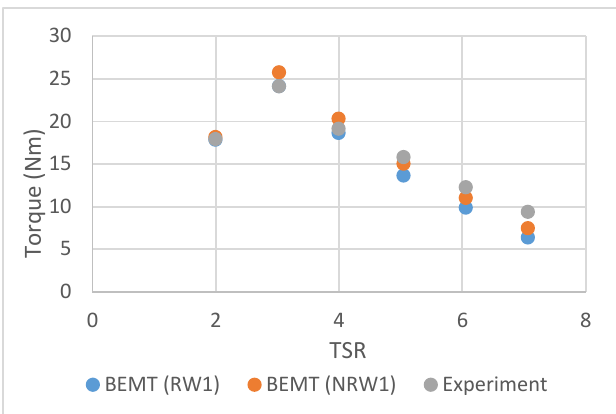
Figure 14. Torque comparison between BEMT calculations and experimental data for the inflow profiles with and without a turbine when the turbine operates under wave-current interactions with a wave height of approximately 0.19m and an apparent wave period of 0.7s.